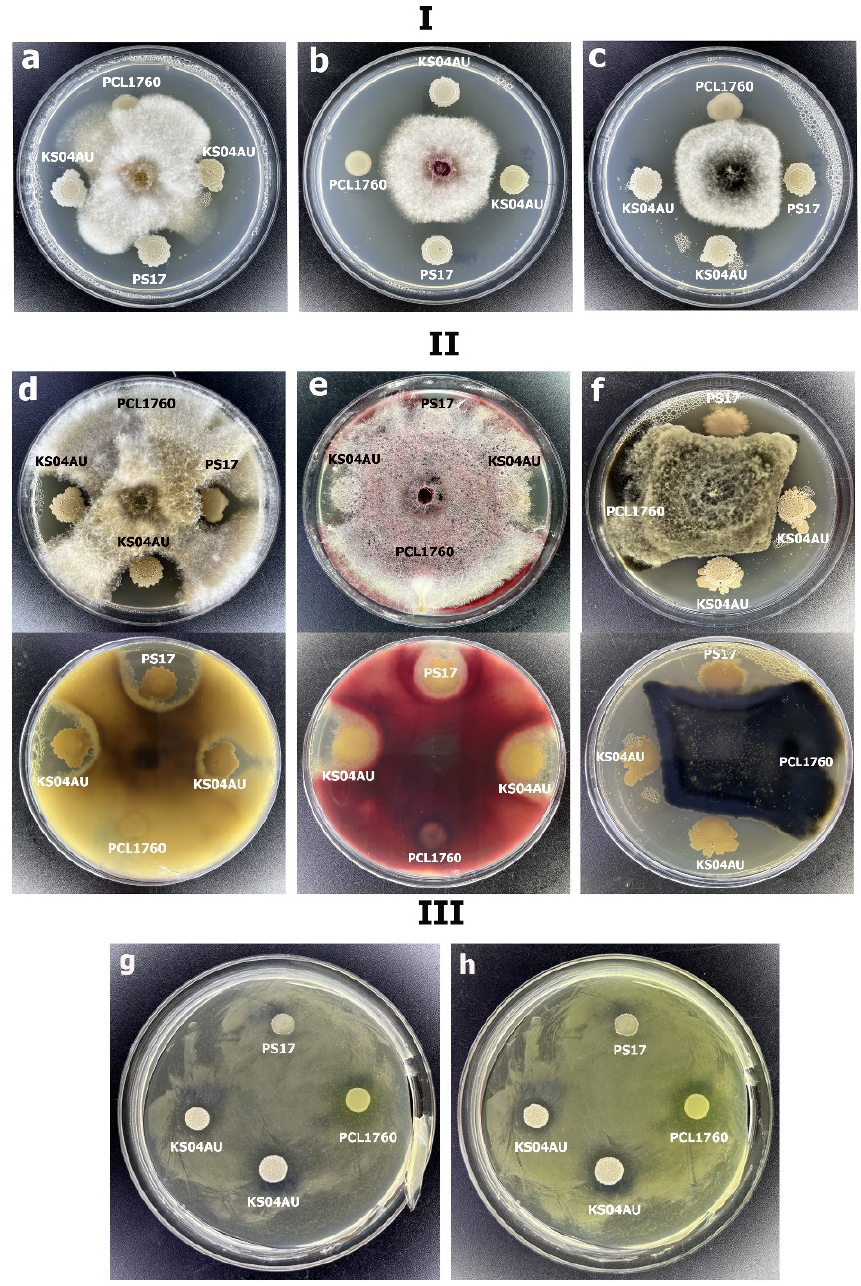
Figure 9. The antagonistic activity of B. velezensis KS04AU against phytopathogenic fungi F. oxysporium ( a , d ), F. graminarium ( b , e ), A. alternata ( c , f ) after 5 days ( I ) and 14 days ( II ) of incubation. The antagonistic activity of B. velezensis KS04AU against phytopathogenic bacteria P. syringae ( III ) after 1 day ( g ) and 2 days ( h ) of incubation.